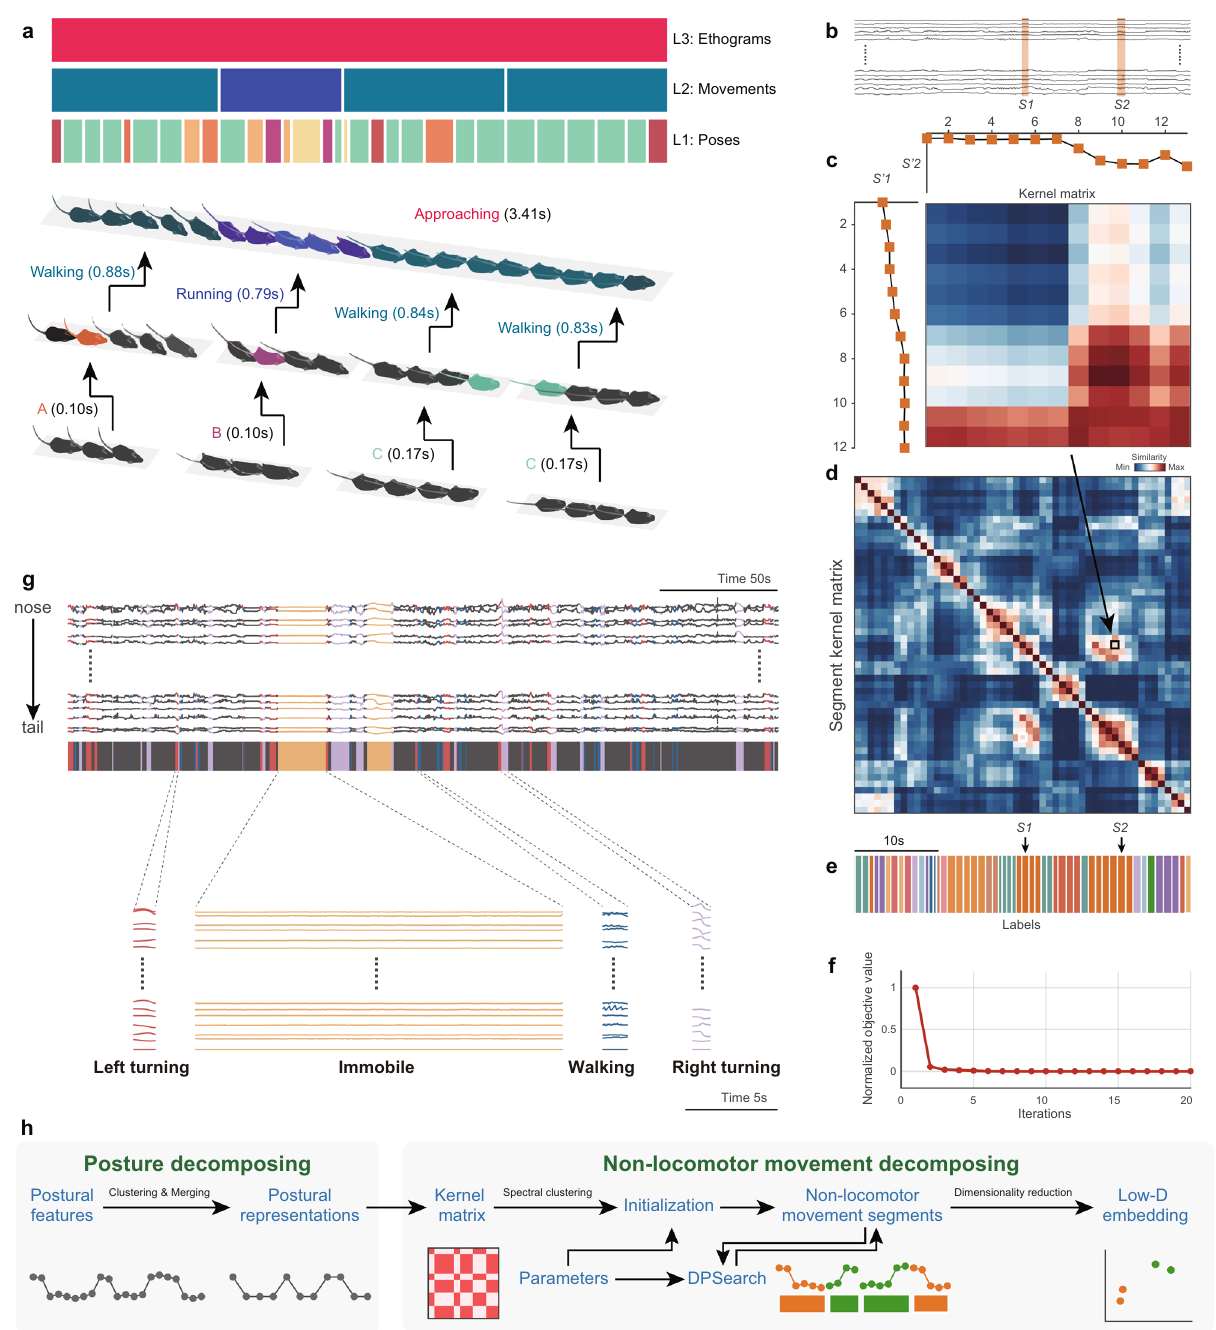
Fig. 3 Dynamic temporal decomposition of multi-scale hierarchical behavior. a Illustration of the three-layer bottom-up architecture for behavior. Top: The color-coded bars indicate the types of behavior components in the corresponding time period at that layer; each upper layer component is composed of the sequence of the lower layer. The instance of “ approaching ” is at the ethogram level which is composed of three movement level sequences, and each movement sequence includes a set of postural representations. b Representative animal postural trajectories (black traces) with two selected similar NM segments S1 and S2 (orange bars masked). c Discrete postural sequences S ’ 1 (12 points) and S ’ 2 (13 points) were decomposed from S1 and S2 and used to calculate their similarity kernel matrix K . d Segment kernel matrix T calculated with DTAK. Each pixel on the matrix represents the normalized similarity value of the K for a pair of segments at the i th row and the j th column (e.g., the pixel in the black box indicates the fi nal similarity of S1 and S2 ). e NM segments decomposed from the postural trajectories shown in b and their color-coded labels. Segments with the same color indicate that they belong to the same types due to their higher similarity. f Optimization process of dynamic temporal decomposition. Objective value (OV) error decreases with each iteration until the termination condition is reached (maximum number of iterations or OV converges). g Top, representative 300-s skeletal traces, where the trace slices highlighted in colors corresponding to the four types of typical NMs (left turn, immobile, walk, right turn). Bottom, magni fi cation of representative traces of these four movement types. h Work fl ow of the two-stage behavioral decomposition. DPsearch dynamic programming